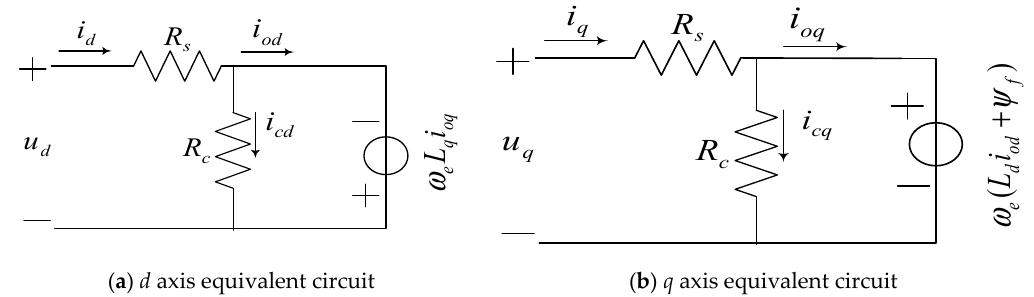
Figure 4. Equivalent steady state circuit of iron loss resistance.